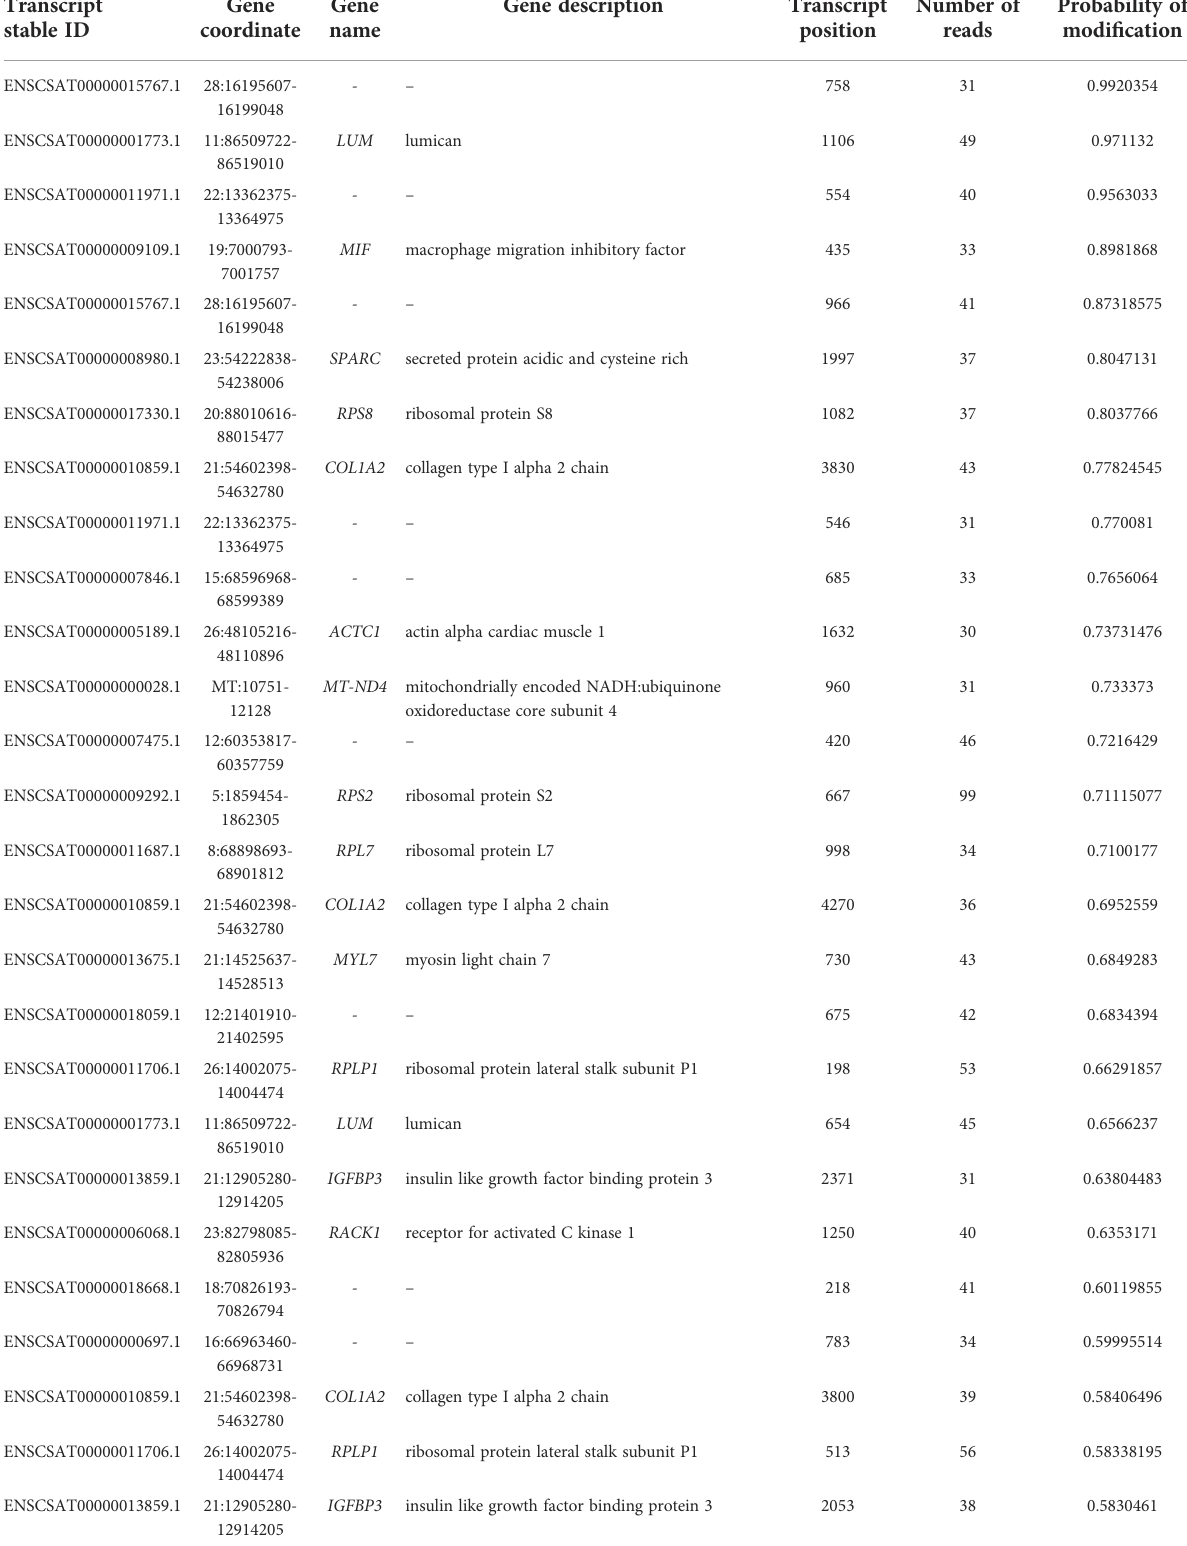
TABLE 2 Distribution of m6A sites in the epitranscriptome of the infected Vero cell sample from (Campos et al.,